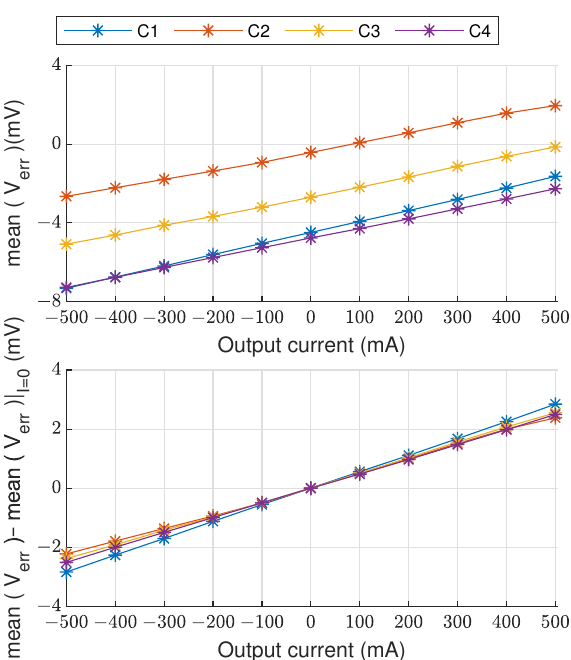
Figure 9. Comparison of the voltage setting error measured on the four samples of the cell emulator. Error as a function of current ( top ). Error when the offset is corrected ( bottom ).